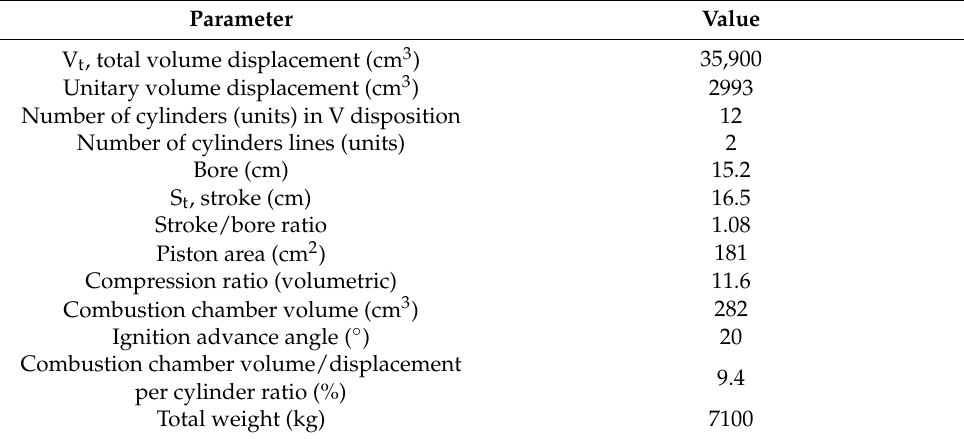
Table 2. Parameters of biogas engines in Burgos